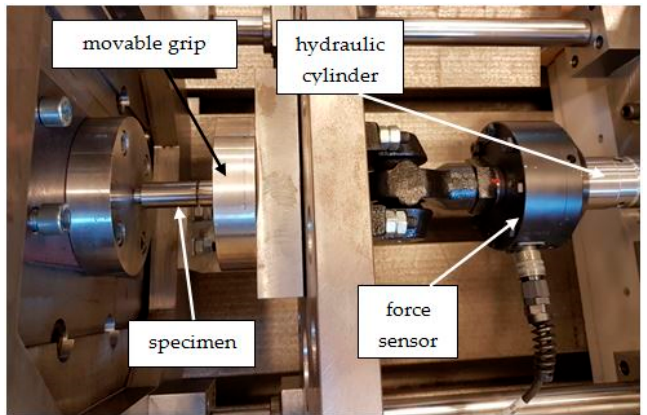
Figure 13. Measuring stand.